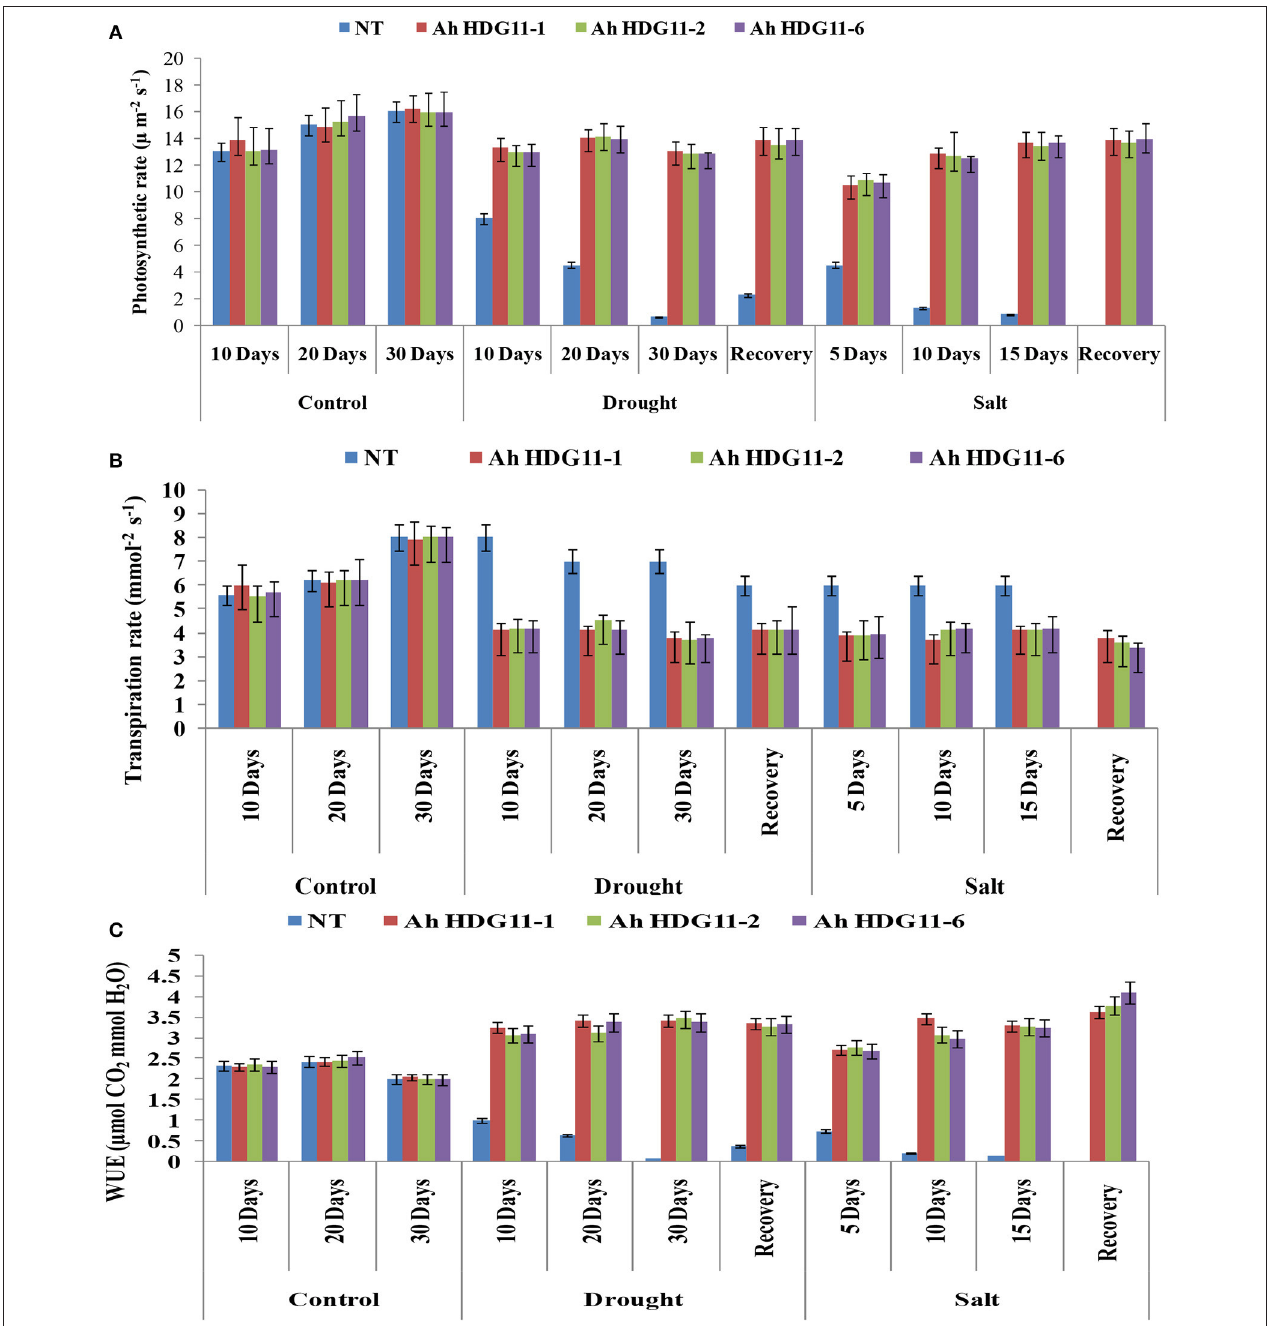
FIGURE 6 | Gas exchange and Water Use Efficiency Analysis of transgenic lines AhHDG11-1, AhHDG11-2, AhHDG11-6 along with the Non-transgenic (NT) plants. (A) Photosynthesis rate (B) Transpiration rate (C) Water Use Efficiency.